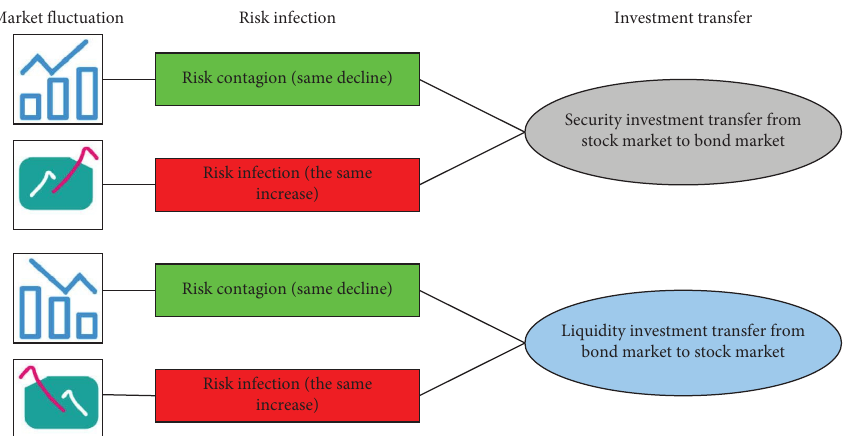
Figure 3: Defnition of the risk contagion and the investment transfer between stock and bond